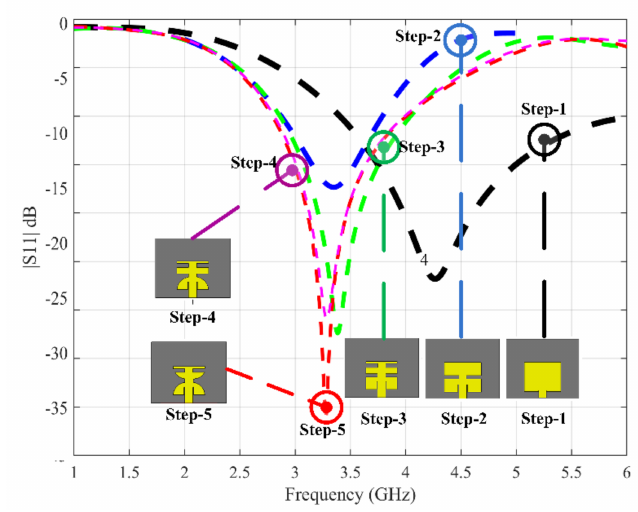
Figure 2. Return loss for different progression stages for mid-band antenna